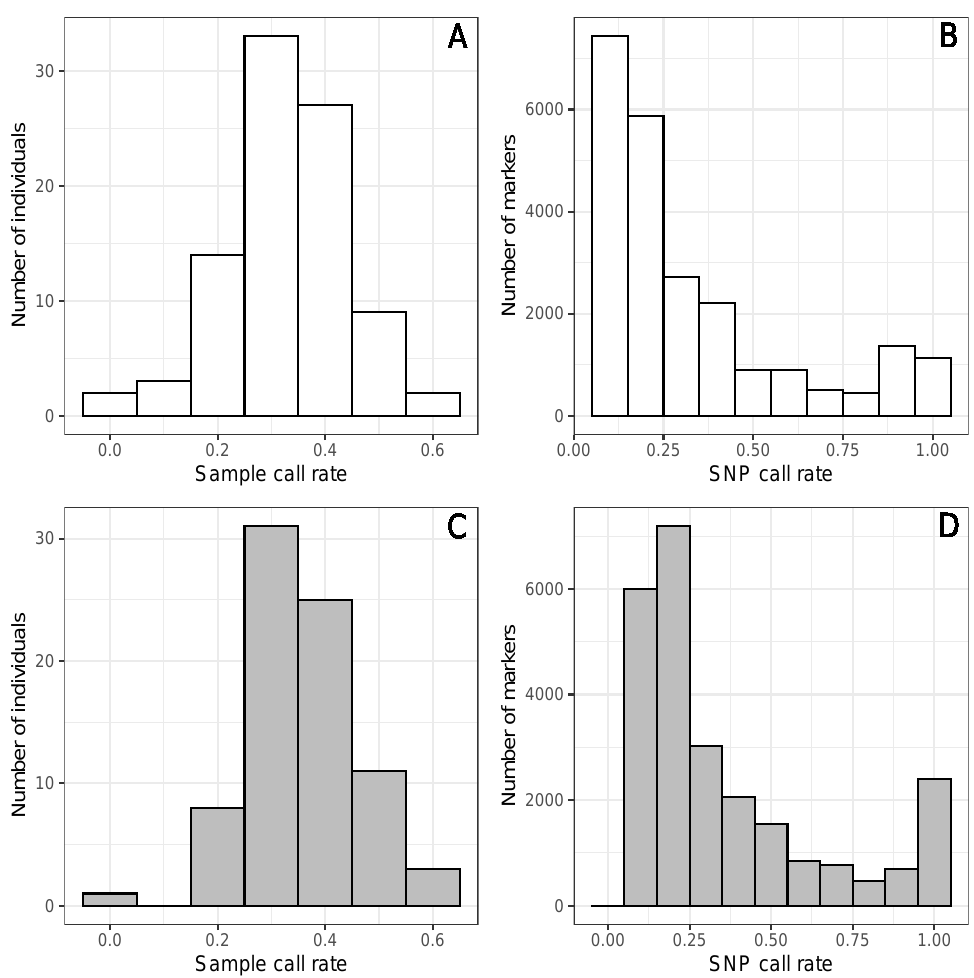
Figure 3. Call rates. Call rates across SNPs and individuals in whole population (plot ( A , B )) and only E. nitens individuals (plot ( C , D